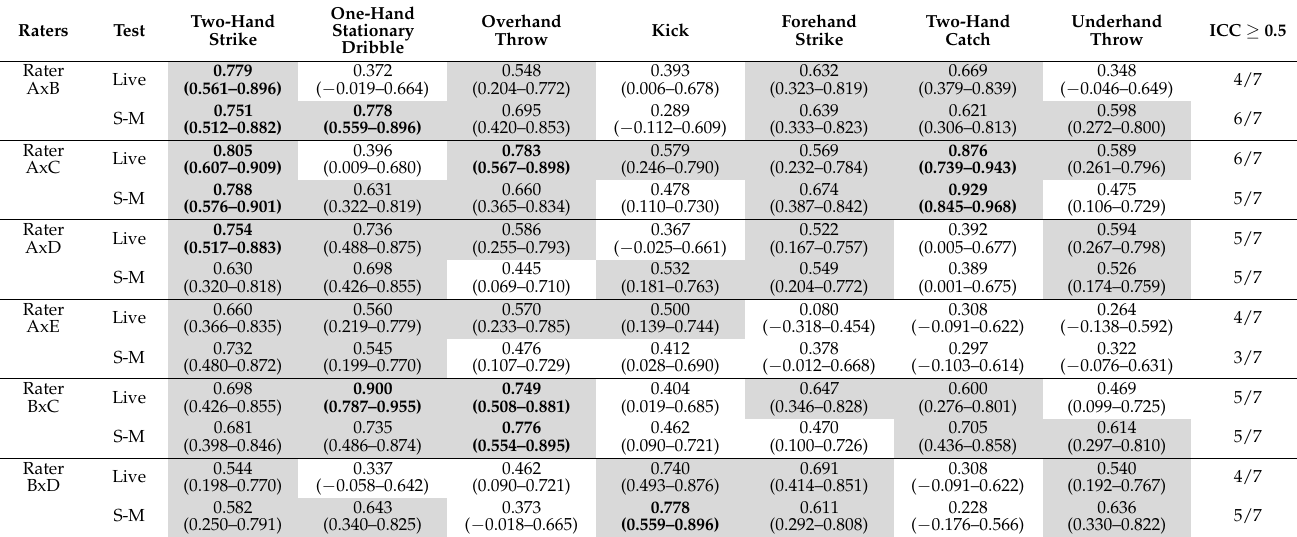
Table 4. Inter-rater reliability * among raters. Ball